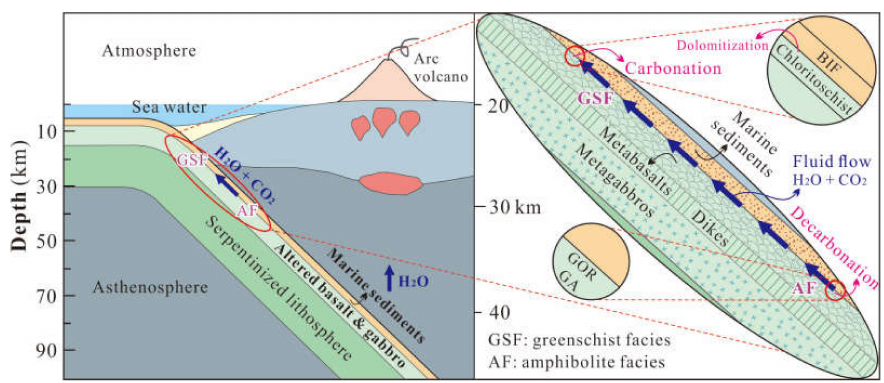
Figure 9. A conceptual schematic illustrating the channelized fluid’s up-dip flow along the sediment– basite interface beneath the leading edge of the forearc in a warm subduction zone. The lithological structure of the subducted slab is modified from [127], and the structure parameters of the hot subduction zone—including slab depth, dehydration loci, and metamorphic facies—follow the numerical simulation results in [128]. The bold arrows represent the fluid flow. The BIF, chlorite schist, garnet amphibolite (GA), and garnet–orthoamphibole rock (GOR) in the Wutai area are labeled at the relevant